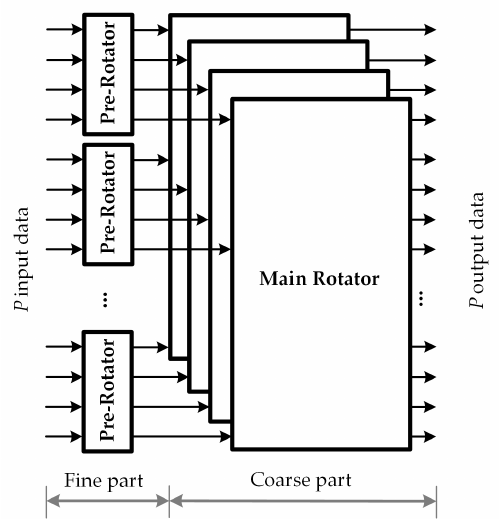
Figure 6. Fine-coarse